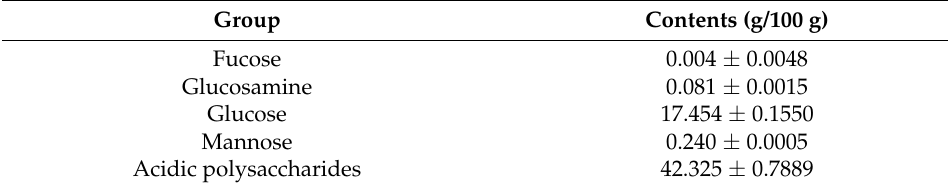
Table 1. Content of monosaccharides and acidic polysaccharides of CTPS.